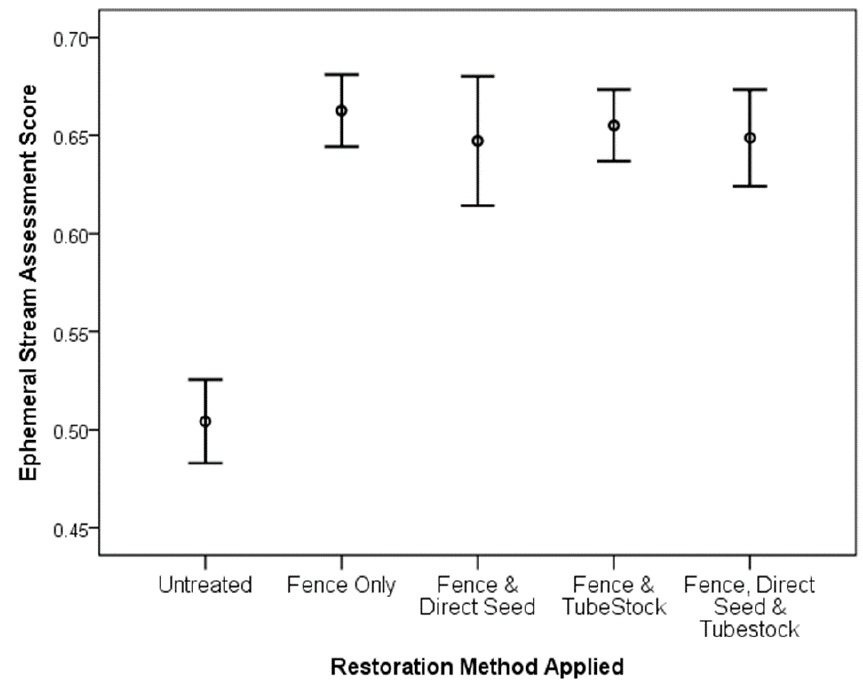
Figure 6. The mean ephemeral stream assessment (ESA) condition scores 10 years after restoration for sites restored as part of the Bidgee Banks Restoration Project (BBRP) using four restoration methods. Untreated site scores are provided as a comparison. Error bars represent ± SE. The maximum achievable ESA score is 1.